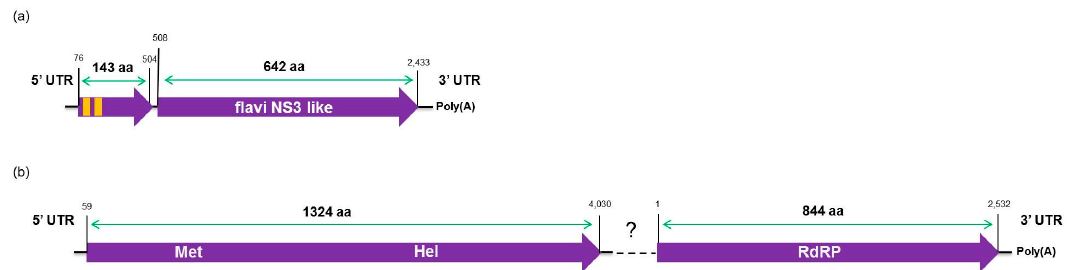
Figure 6. Schematic illustration of the predicted partial genome organization of the two putative novel viruses identified in this study: ( a ) a putative segment 1 of the Citrus jingmen ‐ like virus (CJLV) genome showing two predicted open reading frames (ORFs; purple arrows) and two predicted transmembrane regions (orange boxes); and ( b ) partial Citrus virga ‐ like virus (CVLV) predicted genome showing two predicted ORFs (purple arrows). The detected conserved domains and the amino acid length of each ORF are indicated.